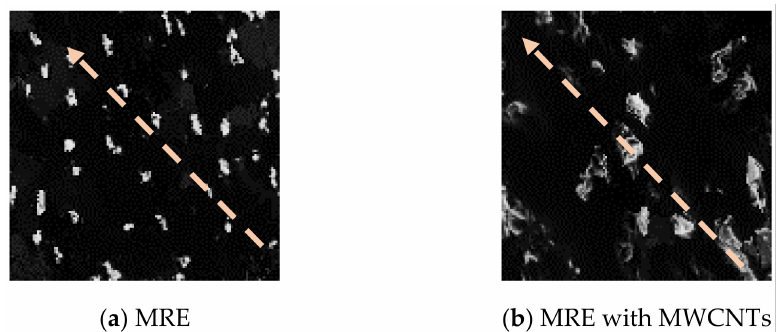
Figure 5. SEM Image at 1000 ×